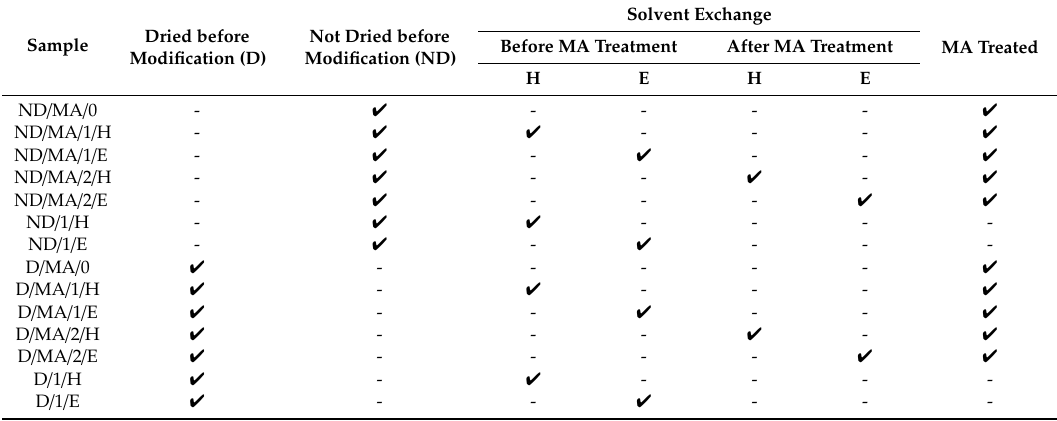
Solvent Exchange